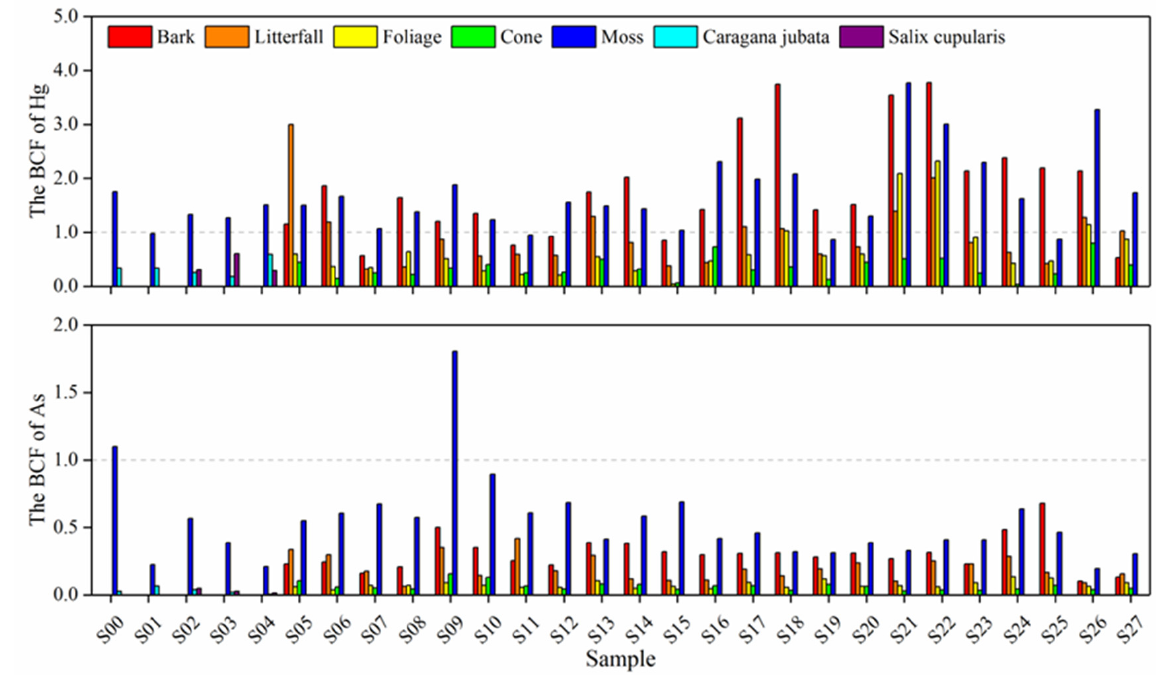
Figure 6. BCF of Hg and As from different plants.